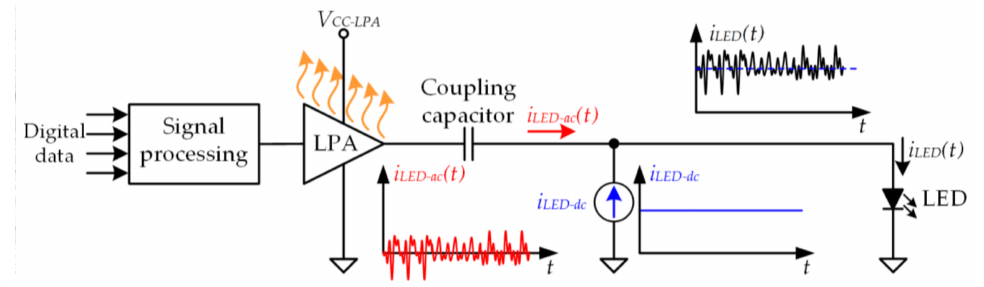
Figure 2. Conventional architecture of a VLC